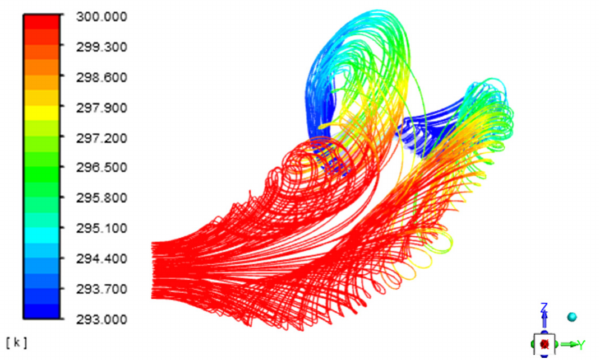
Figure 4. Flow streamline of the thermal jet from the circle discharge port.